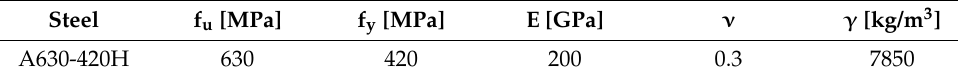
Table 2. Properties of reinforcement